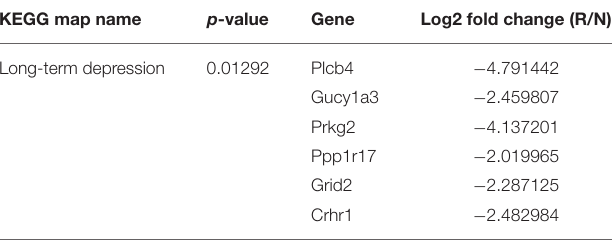
TABLE 5 | The list of chaged gene by restraint stress, fold change means restraint/non-restraint.